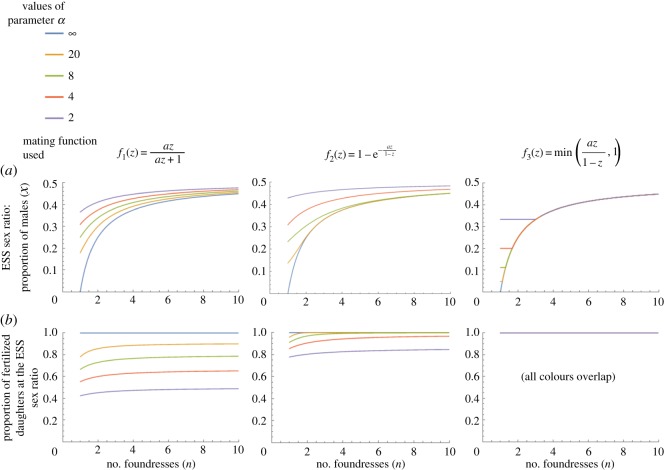
ESS sex ratio (a) and proportion of fertilized daughters (b). (a) How limited insemination capacity (a < ∞) makes the sex ratio deviates from the classic LMC prediction x∗=(n−1)/2n, while a = ∞ reproduces this result. Contrary to verbal predictions, the ESS sex ratio does not necessarily lead to 100% fertilization. The result depends strongly on the mating function. f1 is a common phenomenological model and leads to significant mate limitation at the ESS. f2 is based on the assumption that both sexes can mate multiply, while f3 assumes that females mate once and males multiply given the opportunity. Only f3 agrees with the verbal prediction that all females should be fertilized at the ESS sex ratio.